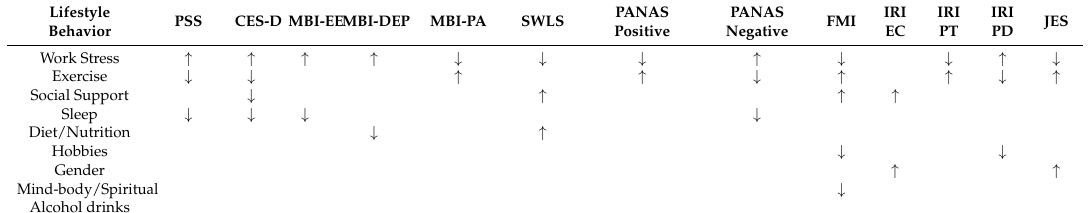
Table 6. Lifestyle behavior predictors and relationship to wellbeing